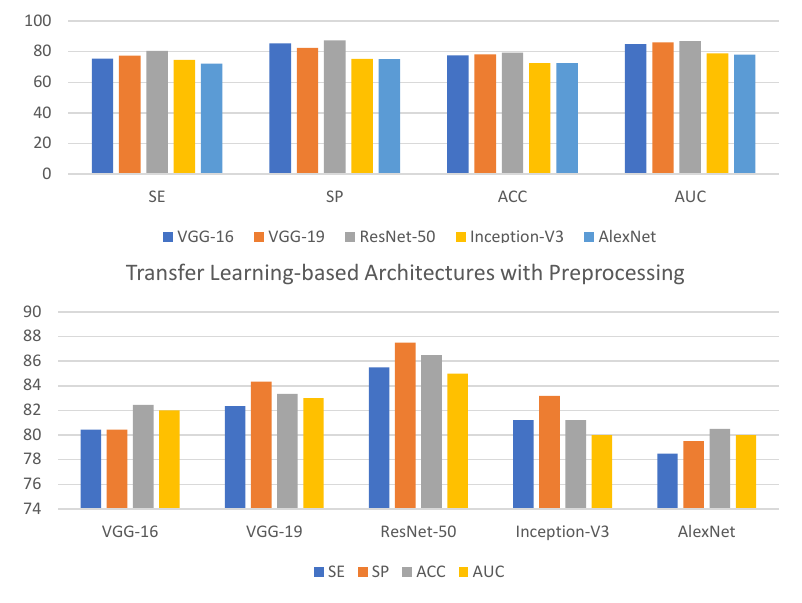
Figure 14. Comparison with other transfer learning-based (TL) CNN architectures for classification of HR based on data augmentation and preprocessing steps.